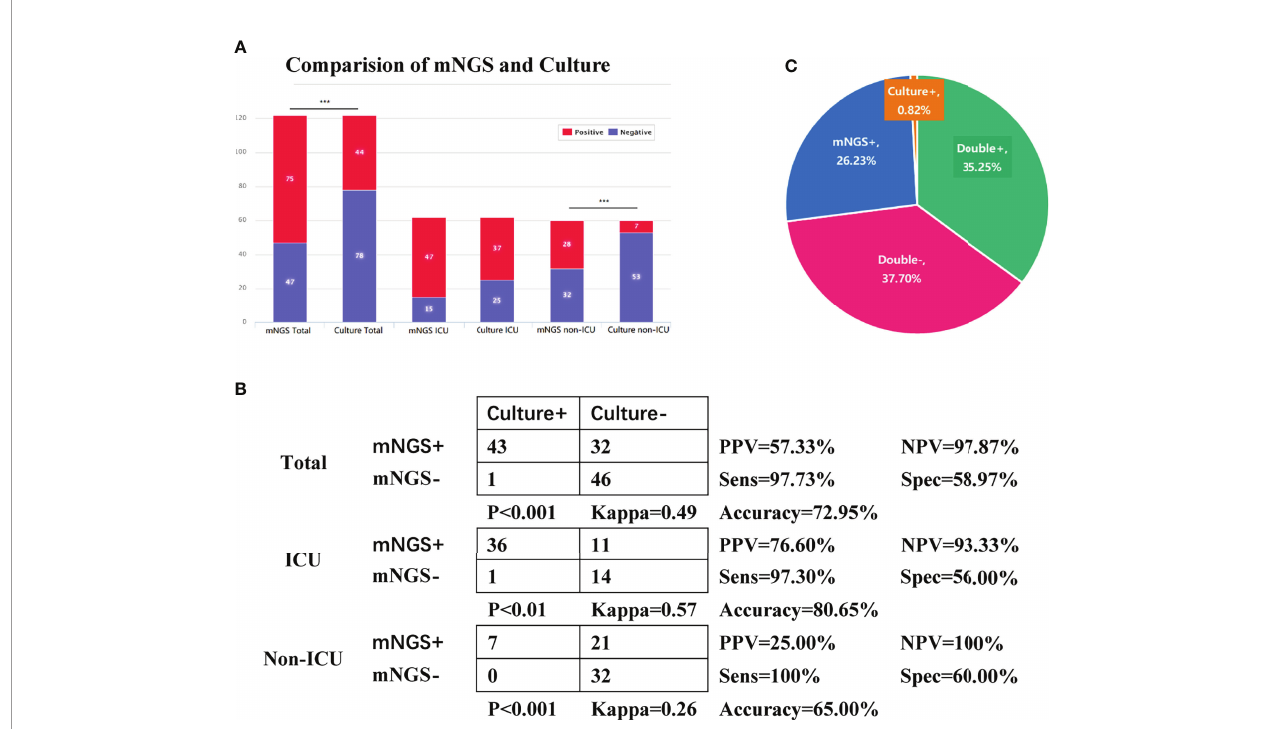
FIGURE 2 | Comparison of overall performance of metagenomic next-generation sequencing (mNGS) and culture in pathogen detection. Tests used Pearson ’ s c 2 test. (A) The number of positive and negative cases in the Total, intensive care unit (ICU), and non-ICU groups of sputum mNGS and culture. (B) Fourfold contingency tables of the sensitivity and speci fi city of sputum mNGS and culture. We assumed sputum culture to be ground truth. Tests used McNemar ’ s chi-square test. (C) Pie chart of the positivity distribution of mNGS and culture. Abbreviations: PPV, positive predictive values; NPV, negative predictive values; Sens, sensitivity; Spec, speci fi city. Due to the limitations of culture-based methods in detecting certain opportunistic pathogens, fungi, and viruses, we decided to exclude Haemophilus spp., Candida albicans , Enterococcus spp., and viruses from the mNGS results before comparing the overall performance of these two methods in pathogen detection. Only one C. albicans was reported positive in sputum culture, and because of its massive growth, the corresponding mNGS result was listed. Since the bacteria and fungi in the RNA fl ow results were all included in the DNA fl ow, mNGS data were based on the data of the DNA fl